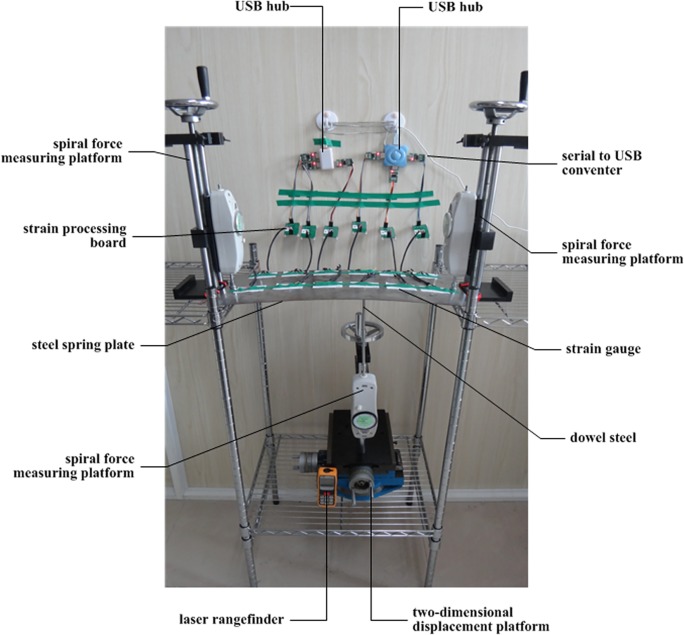
Experimental system.